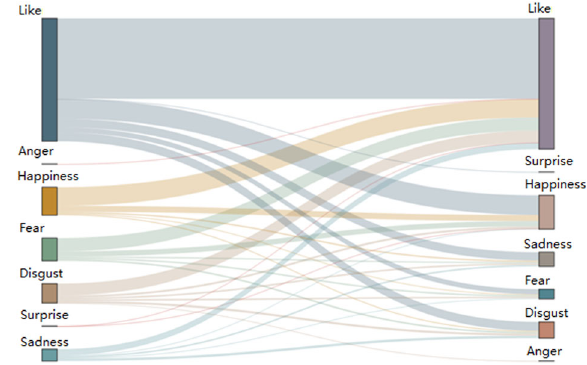
Fig. 4 Changes of emotions of 1149 users before and after lockdown. The changes of emotions of 1149 users before and after lockdown, with the widths of fl ows representing the numbers of